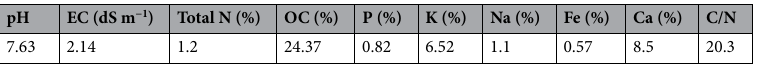
Table 1. Initial vermicompost